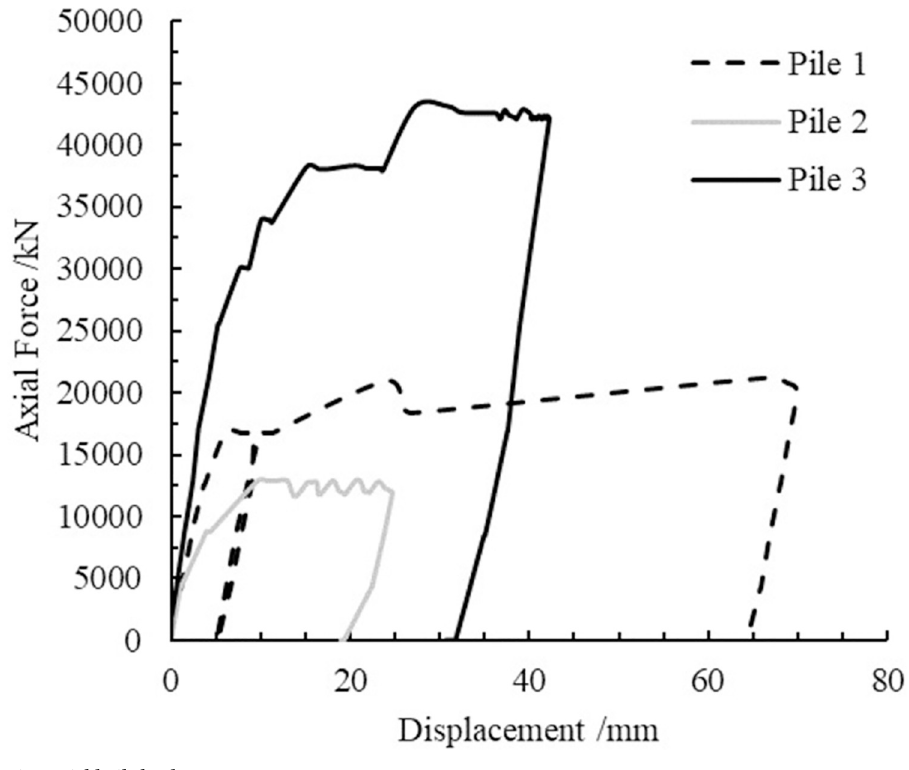
Fig 1. Field pile load